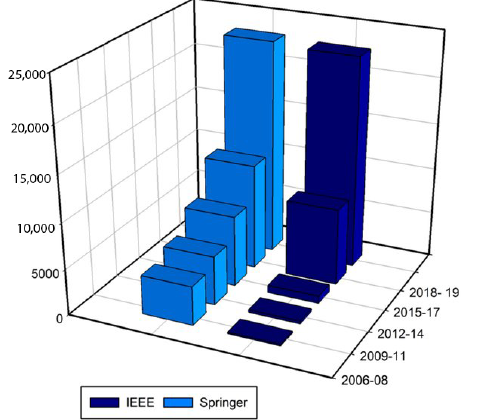
Figure 2. Publication analysis in Springer database and the IEEE digital